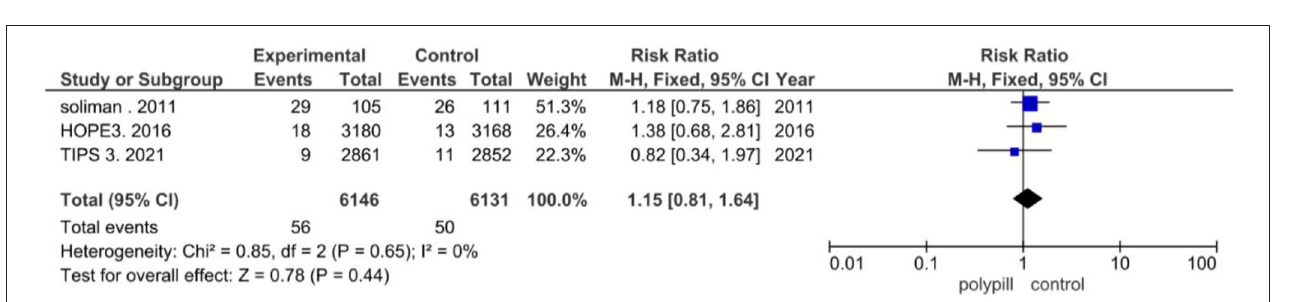
FIGURE 8 | Forest plot of treatment discontinuation due to adverse events.